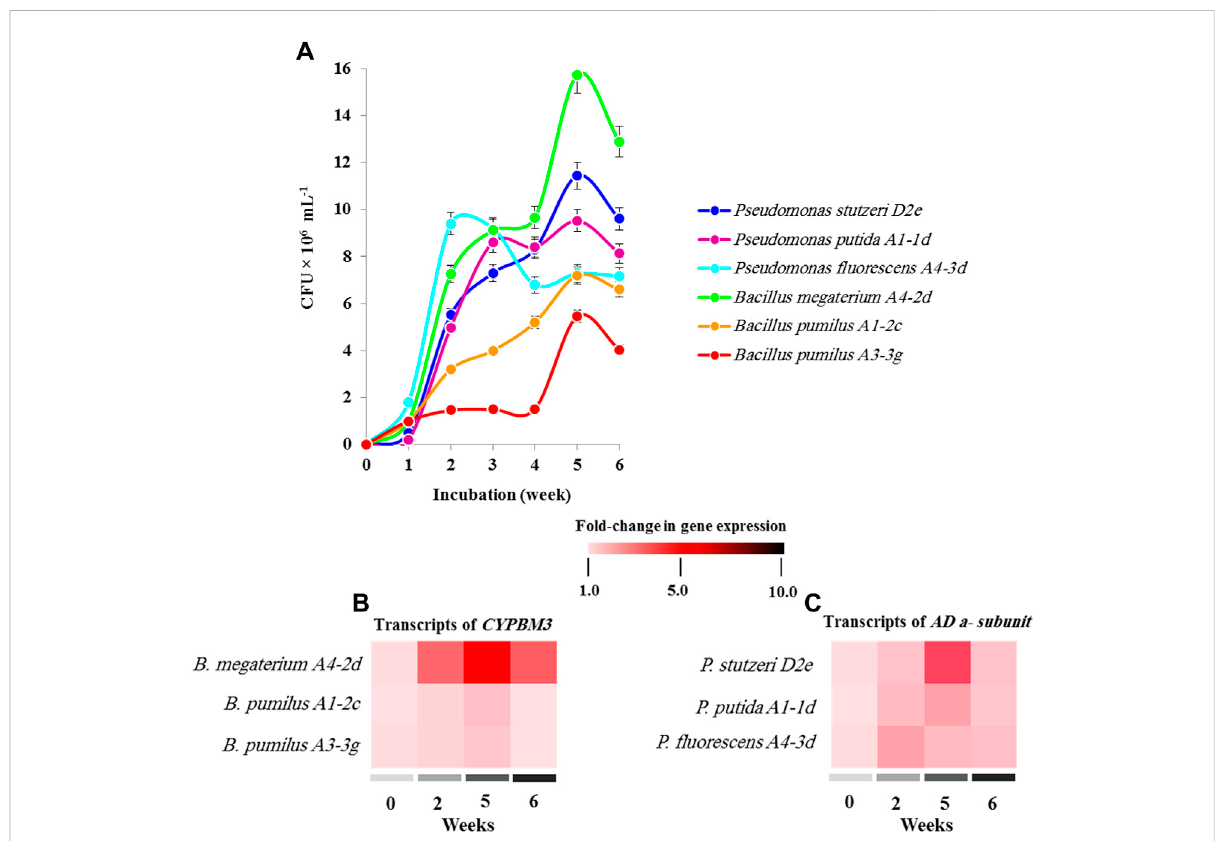
FIGURE 5 Functional identi fi cation of 2,3,7,8-TCDD-degrading bacteria. (A) The functionality of dioxin-biodegrading genes ( AD and CYPBM3 ) was assayed by evaluating bacterial growth on 2,3,7,8-TCDD, as sole carbon source in a laboratory-scale experiment. The growth of each strain was expressed as CFU × 10 6 ml − 1 per week for a period of 6 weeks. (B,C) The transcripts levels of CYPBM3 and AD α -subunit genes in different strains growing in the presence of 2,3,7,8-TCDD at 2, 5 and 6 weeks. The colour scale (white-red-black) indicates relative changes of transcript abundance of 1, 5 and 10 fold, respectively. All measurement were performed in triplicates. Values are means ± S.D ( n =